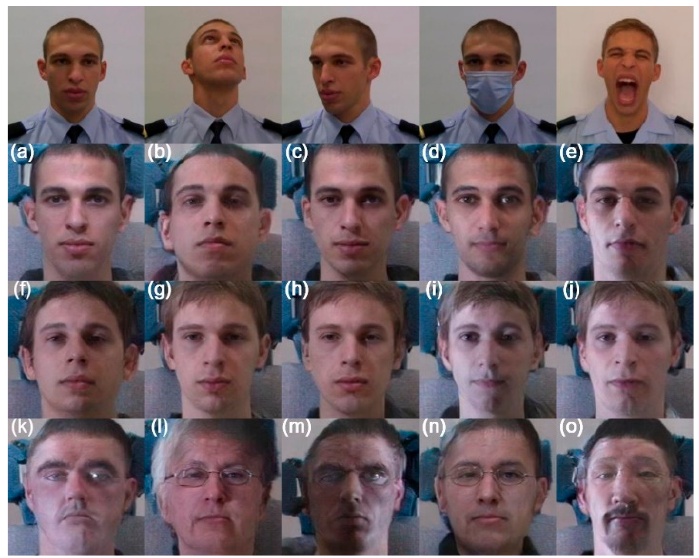
Figure 11. Results achieved by the FNM in the different spectral bands. The images on the top are the originals in the VIS. The images ( a – e ), ( f – j ), and ( k – o ) were generated by the proposed methodology when it receives as input the images from the VIS, NIR and LWIR bands, respectively.